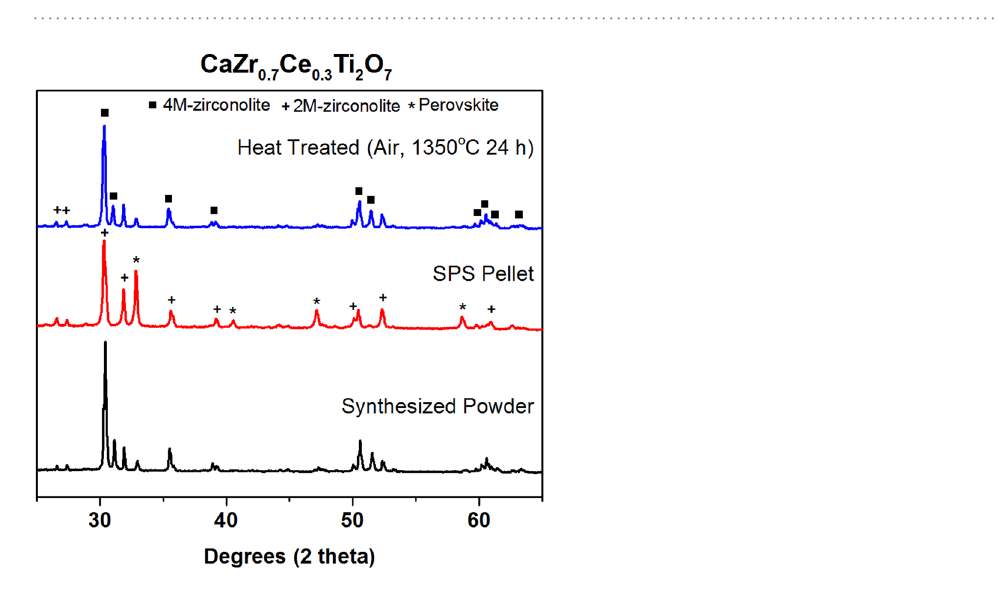
Figure 9. XRD patterns comparing the phase assemblage in CaZr 0.7 Ce 0.3 Ti 2 O 7 under different processing